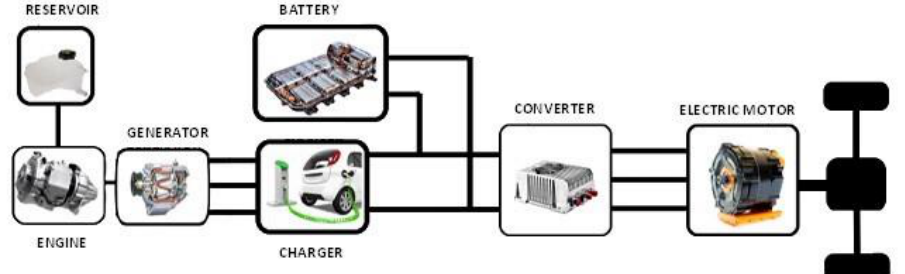
Figure 1. Schematic of series hybrid electric vehicles (SHEV).